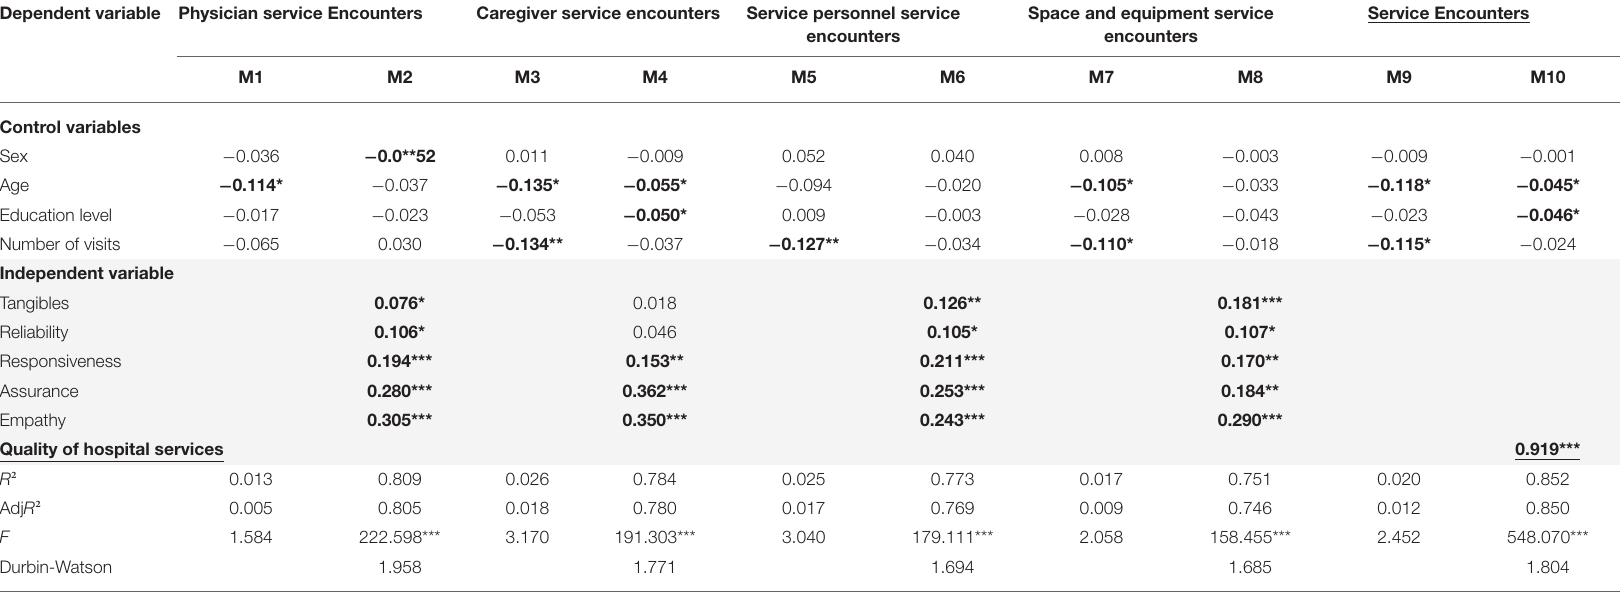
TABLE 7 | Regression analysis of hospital service quality and satisfaction with the experience after service encounter ( n = 483). Dependent variable Physician service